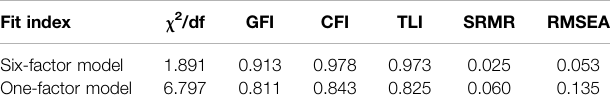
TABLE 3 | Con fi rmatory factor analysis ( N (cid:1)